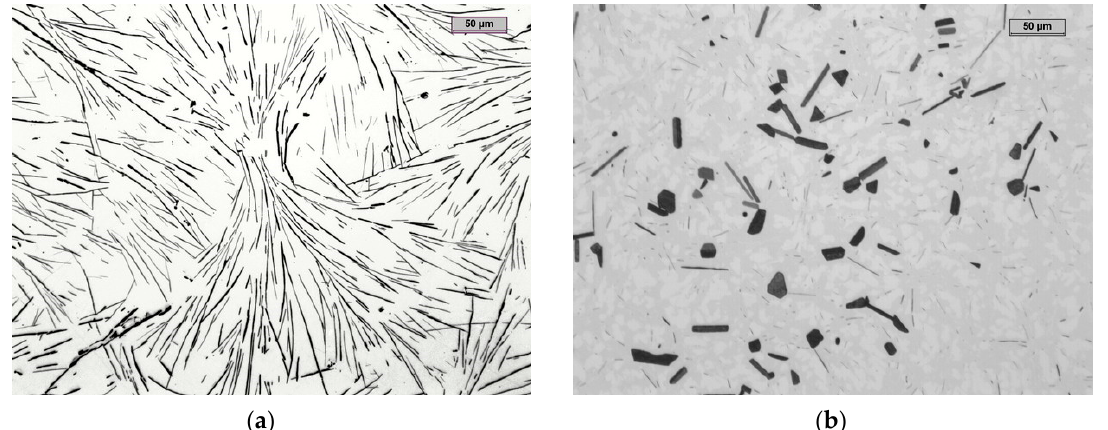
Figure 11. The microstructure of a sample made from high-aluminum cast iron with the addition of chromium, eutectic structure as cast ( a ) and hypereutectic structure after heat treatment ( b ).